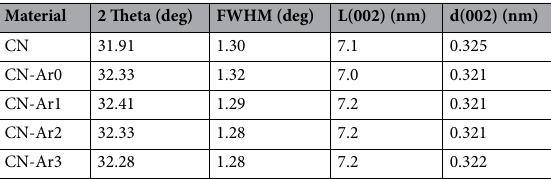
Table 2. Basic XRD characteristics of CN and CN-Ar